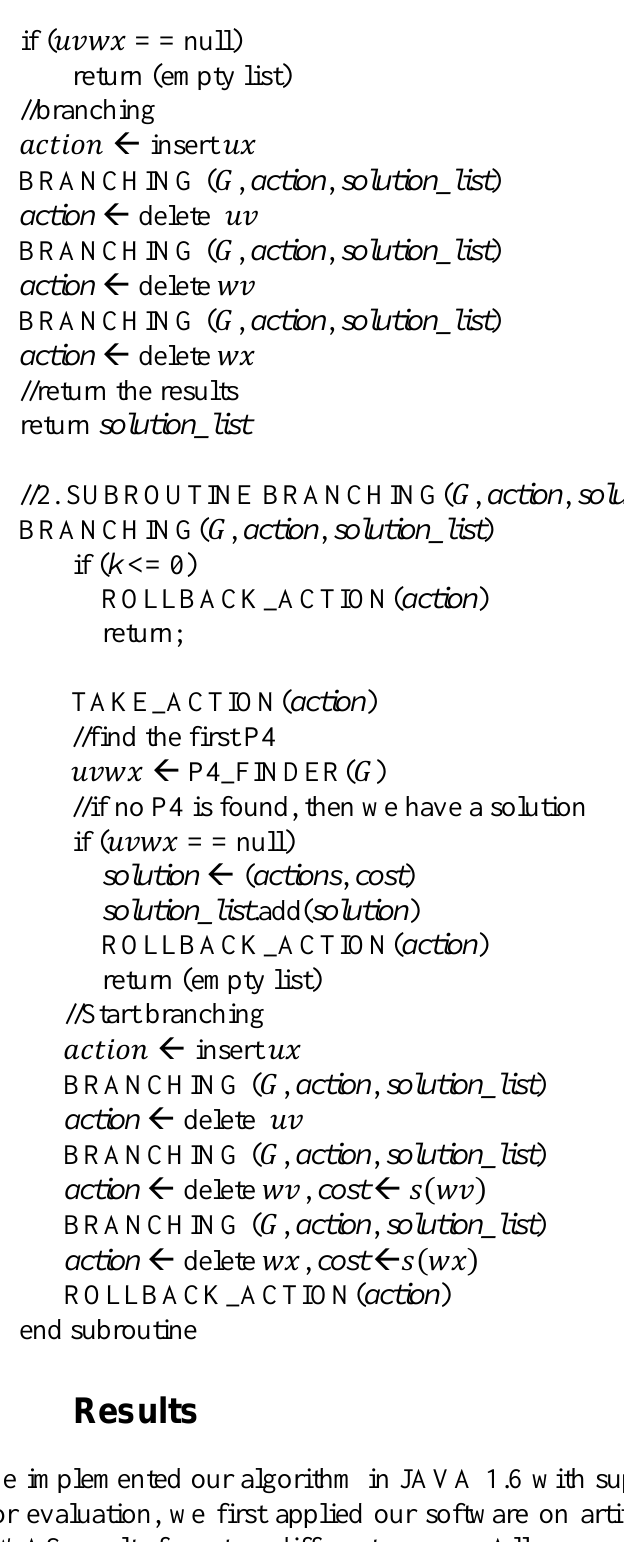
Figure 2. The graph cluster editing strategy based on P4-branching. Blue dashed lines relate to edge deletion and red dashed line corresponds to edge insertions. There are four options